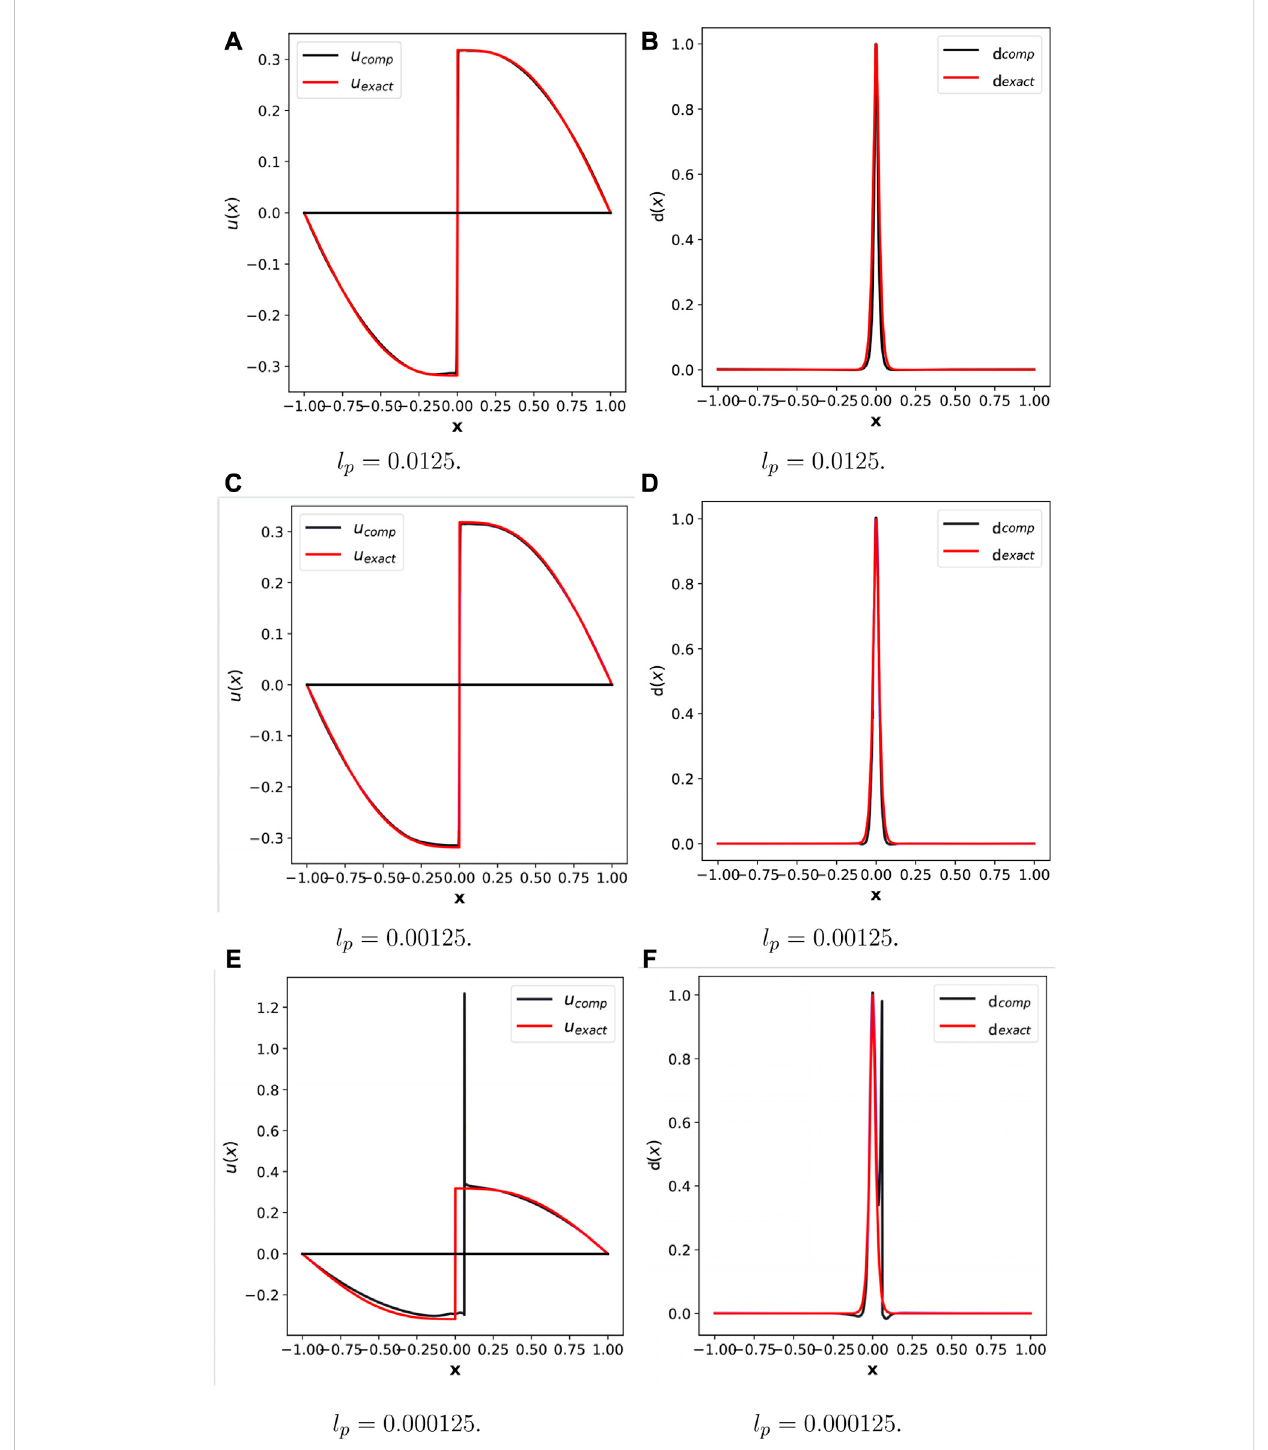
FIGURE 4 1D elastic bar with crack using variation energy based PINN. Left column compares the exact displacement u exact and the computed displacement u comp . The right column compares the exact phase fi eld d exact and the computed phase fi eld d comp . (A) l l p = 0.00125, (E) l p = 0.000125, (F) l p =